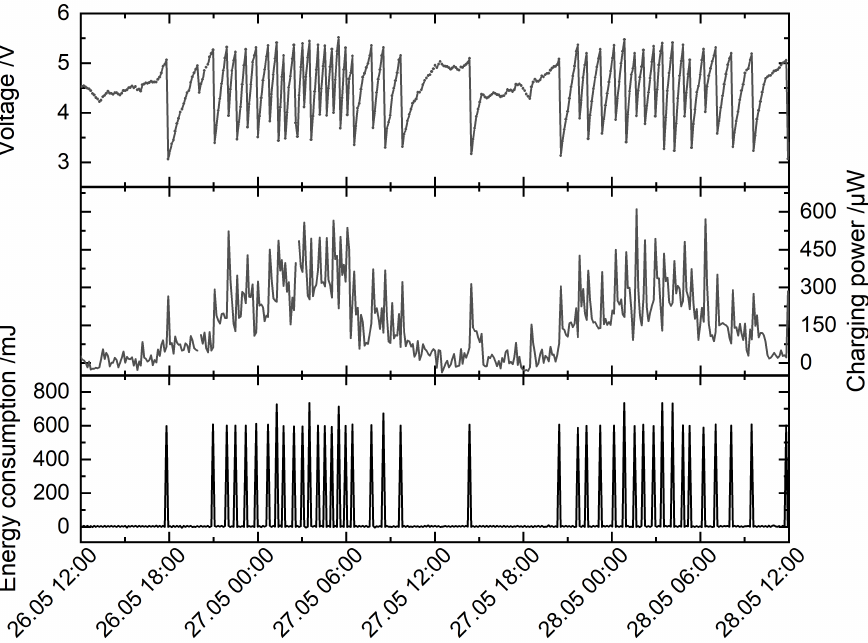
Figure 13. Voltage, charging power, and power consumption of tracker 1 for the first two